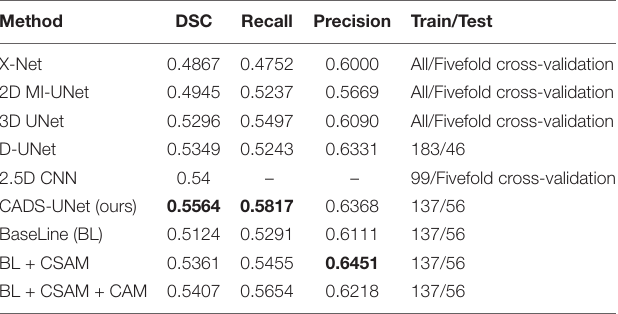
TABLE 2 | Comparison with other state-of-the-art methods and ablation studies on the ATLAS